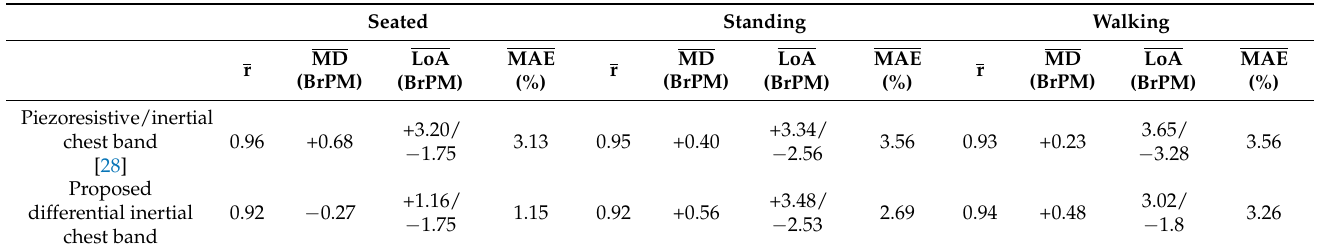
Table 6. Performance comparison of piezoresistive/inertial and differential inertial chest bands considering the user seated, standing, and